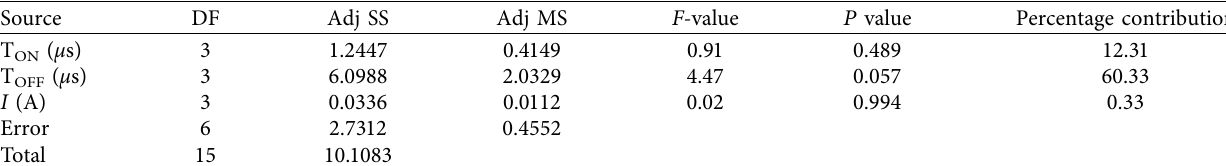
Table 5: Results of ANOVA for